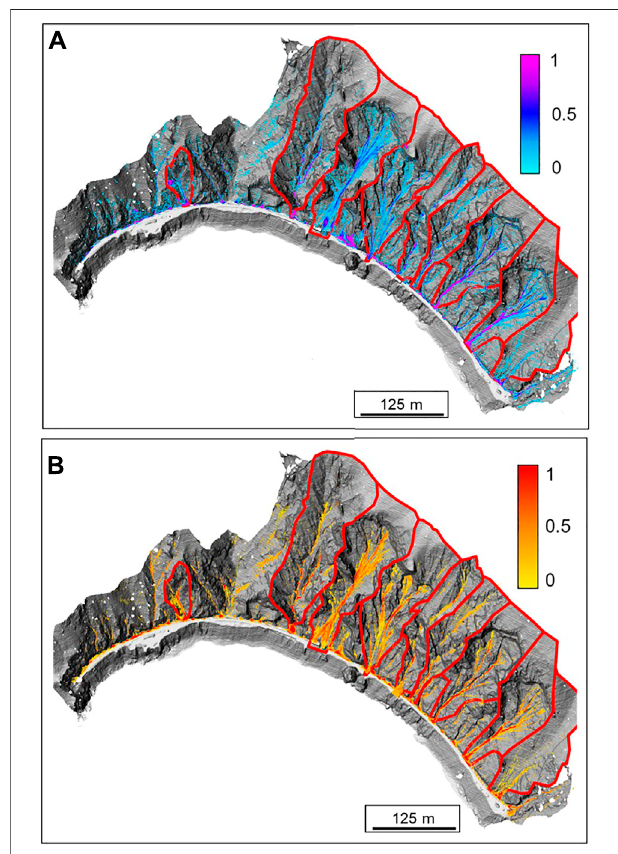
FIGURE 11 | Normalized cumulative heatmap for WCE. (A) Overview of the negative change and (B) overview of the positive change.